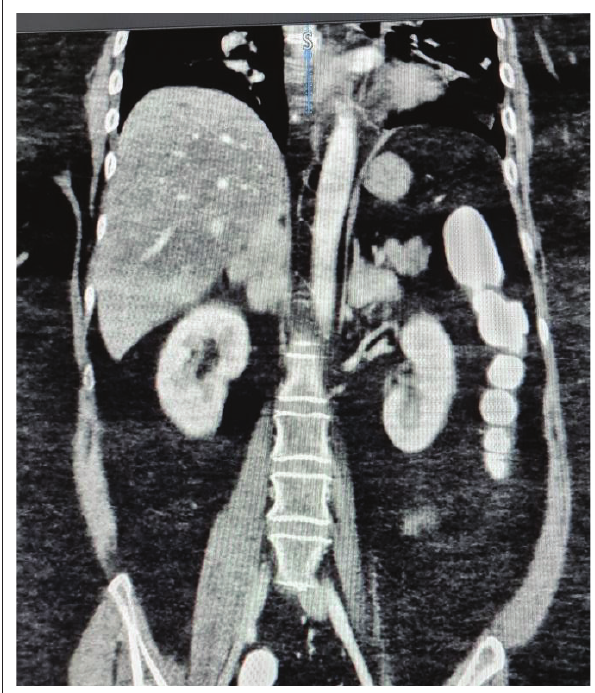
FIGURE 1: Computed tomography (coronal view) demonstrating bilateral adrenal hyperplasia with the right adrenal gland measuring 44.7 mm × 30.3 mm and the left adrenal gland measuring 25.0 mm × 27.7.mm.